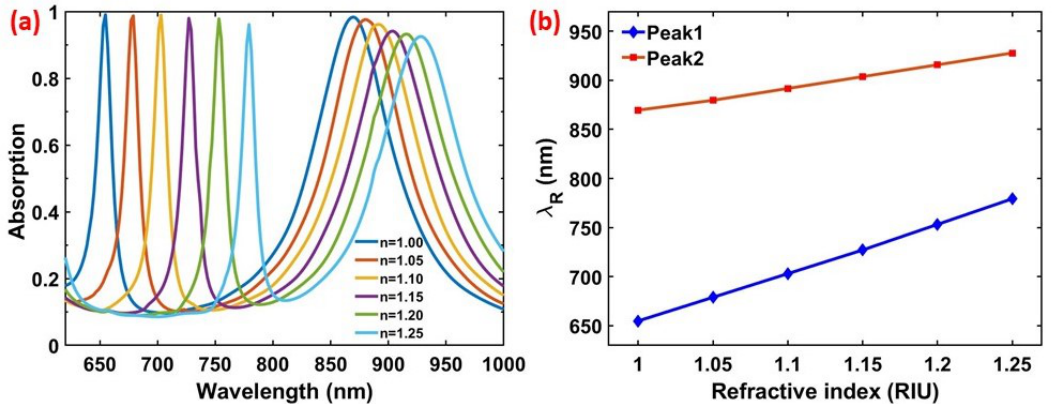
Figure 7. ( a ) Simulated absorption spectra of the PA within different refractive index backgrounds; a 0.05 RIU change delivers a significant traceable red shift. ( b ) The relation between Peak1 and Peak2 resonance wavelengths ( λ R ) with the surrounding refractive index. The sensitivity (slope) for both peaks are calculated as S 1 ≈ 500 nm/RIU and S 2 ≈ 235 nm/RIU.